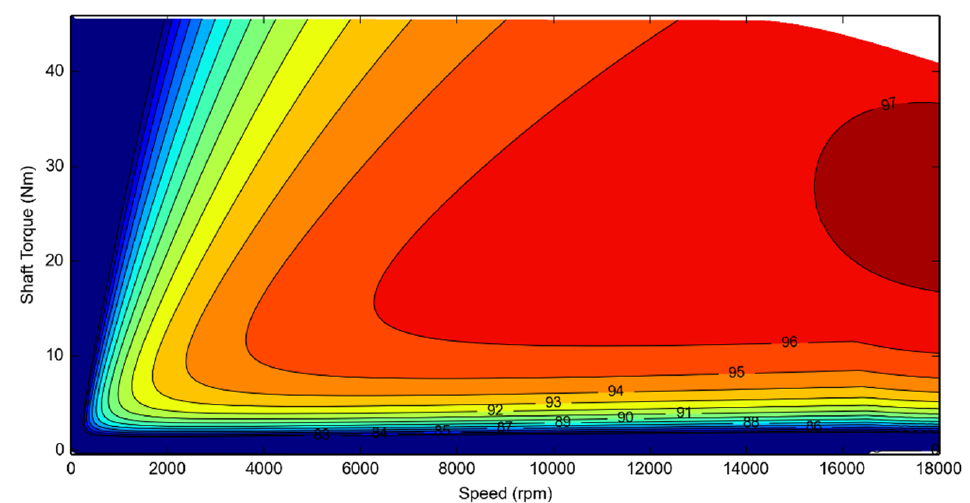
Figure 8. Efficiency map of the whole speed range.